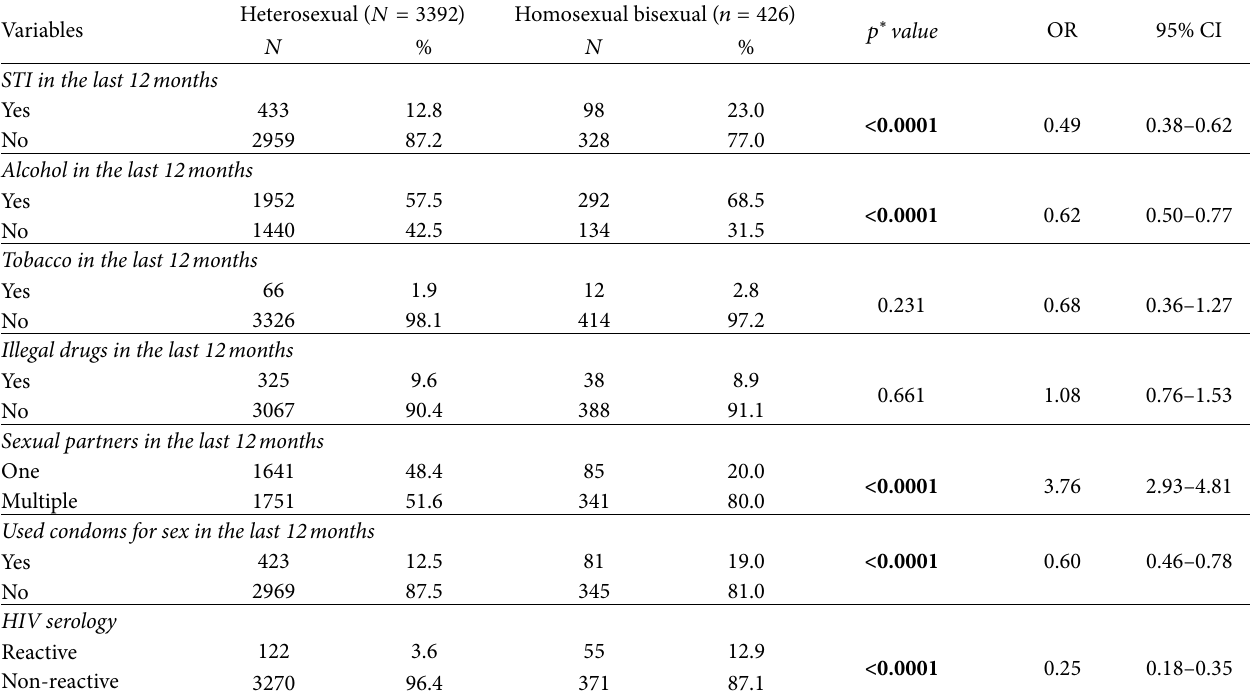
Table 1: Distribution of behavioral variables according to sexual orientation ( 푛 = 3,818